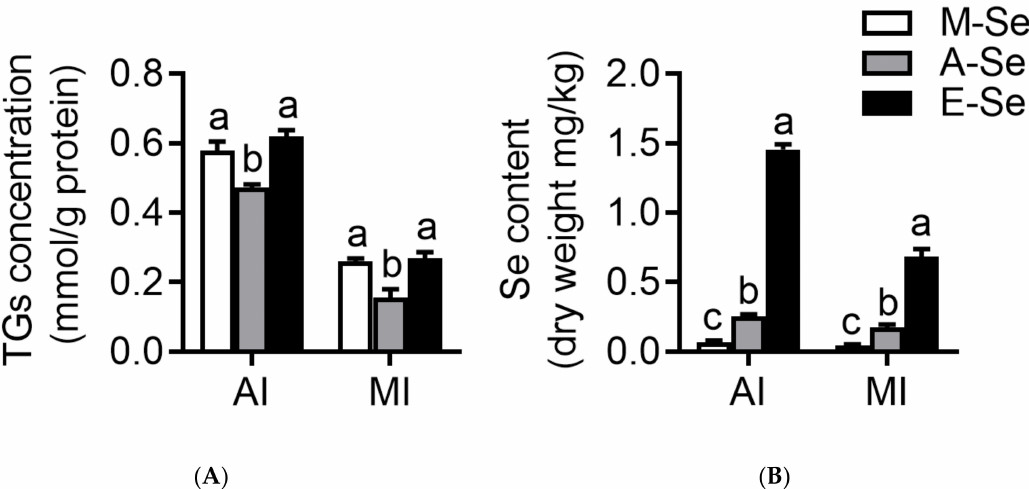
Figure 3. AI and MI TGs concentration ( A ) and Se content ( B ) in yellow catfish fed diets varying in Se level for 12 wk. Values are means ± SEMs, n = 3 (replicates of 3 fish). Labeled means without a common letter differ, p < 0.05 (one-factor ANOVA, Duncan post hoc test).